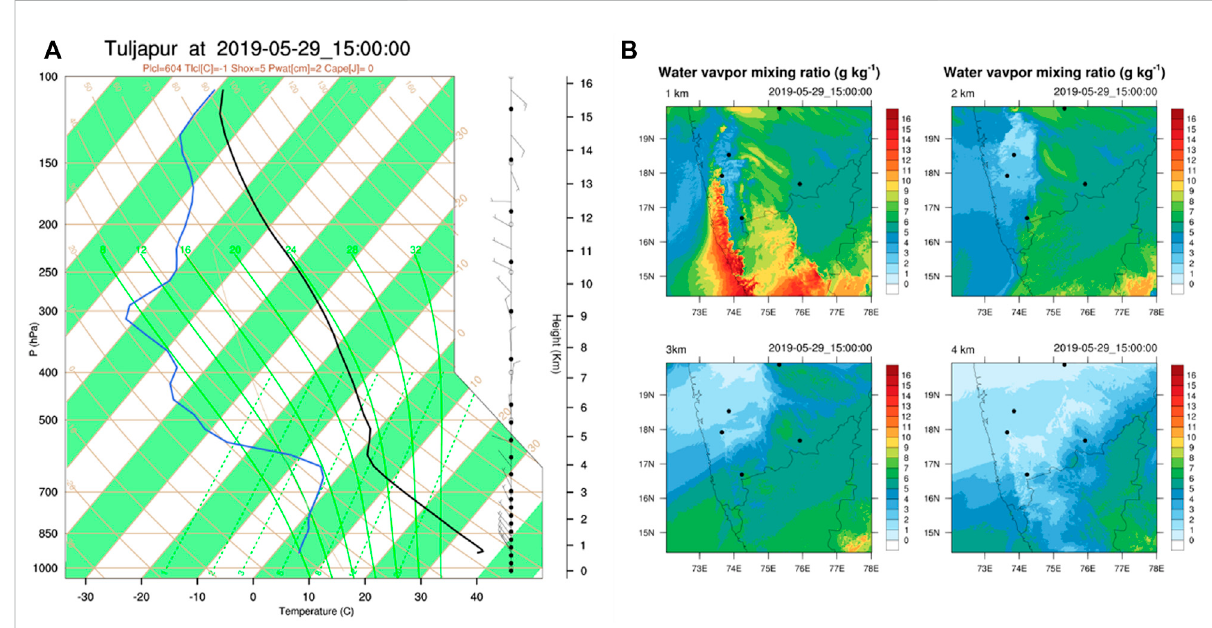
FIGURE 3 (A) SkewTfromWRFmodel(bluelineisdewpointtemperature,blacklineisdry bulbtemperature,windsareshownwith windbarbs)atTuljapur on 29 May 2019 at 1500 UTC. (B) The spatial distribution of water vapour mixing ratio at four different altitudes.